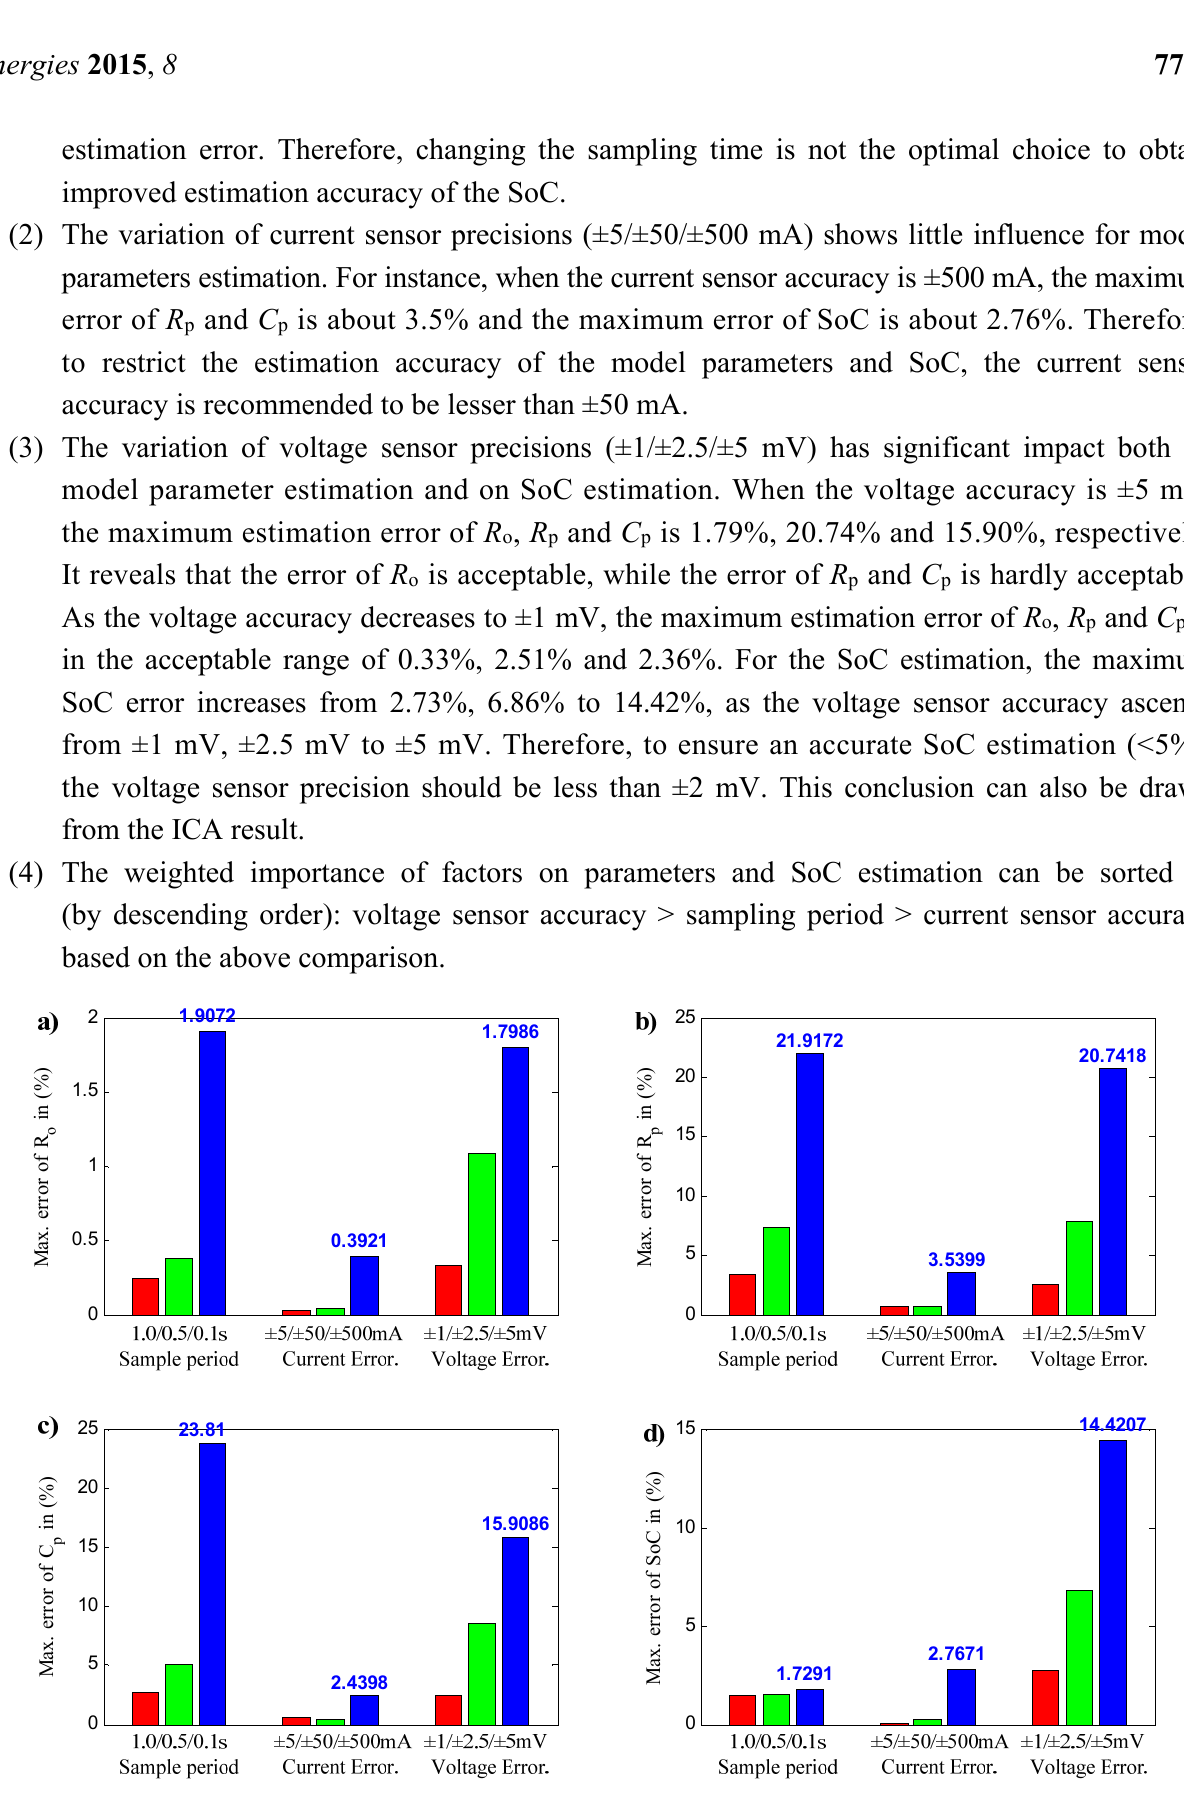
Figure 12. Comparison of three factors on the stability of model parameters and SoC estimation: ( a ) R o , ( b ) R p , ( c ) C p , and ( d )